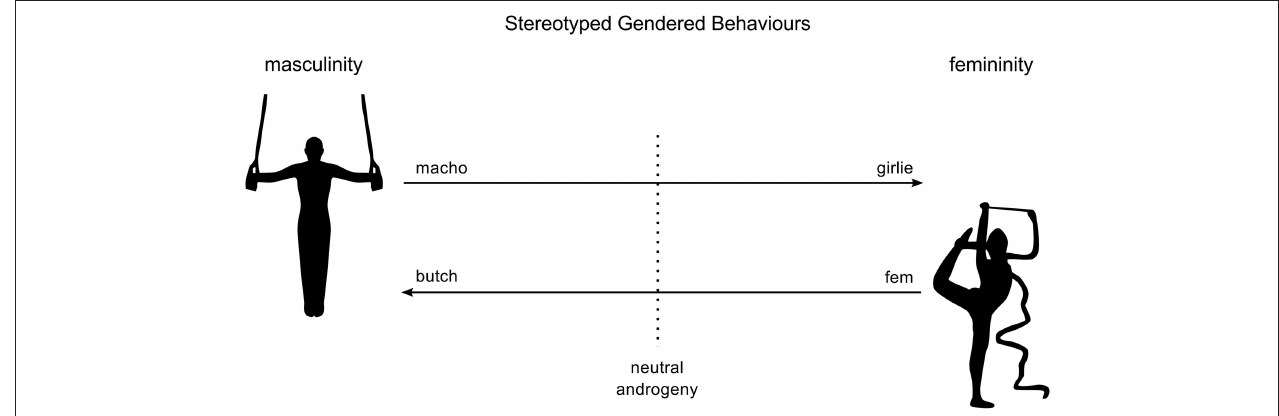
FIGURE 2 | Directional trends of gendered